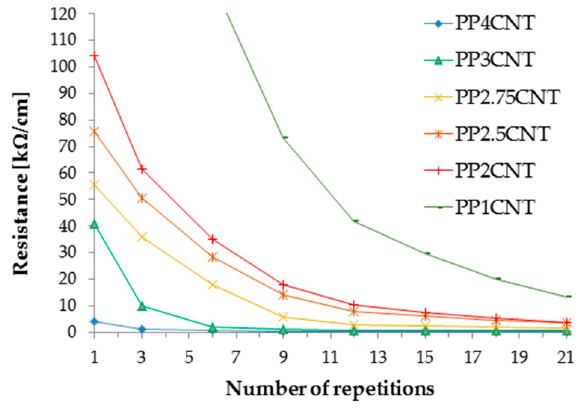
Figure 3. Decrease in track resistance with the number of laser treatments performed on polypropylene–ethylene copolymer (PP)/carbon nanotube (CNT) composites (P = 35%, scan rate = 200 mm/s, F = 15 kHz, defocus = 0 mm).